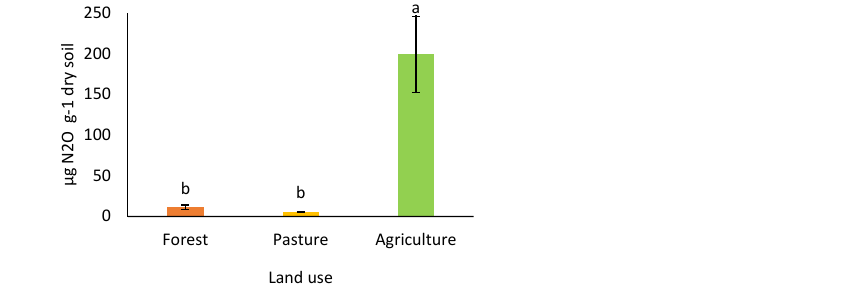
Figure 2. N 2 O fluxes (ng N 2 O g -1 dry soil day -1 ) in different land uses in the Brazilian Amazon.